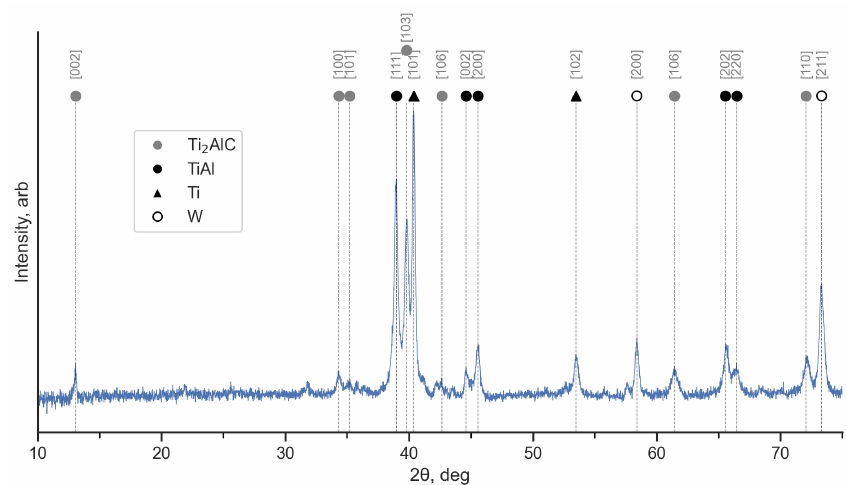
Figure 3. XRD spectrum of the TAW2 sample after HIP at 1000 ◦ C.